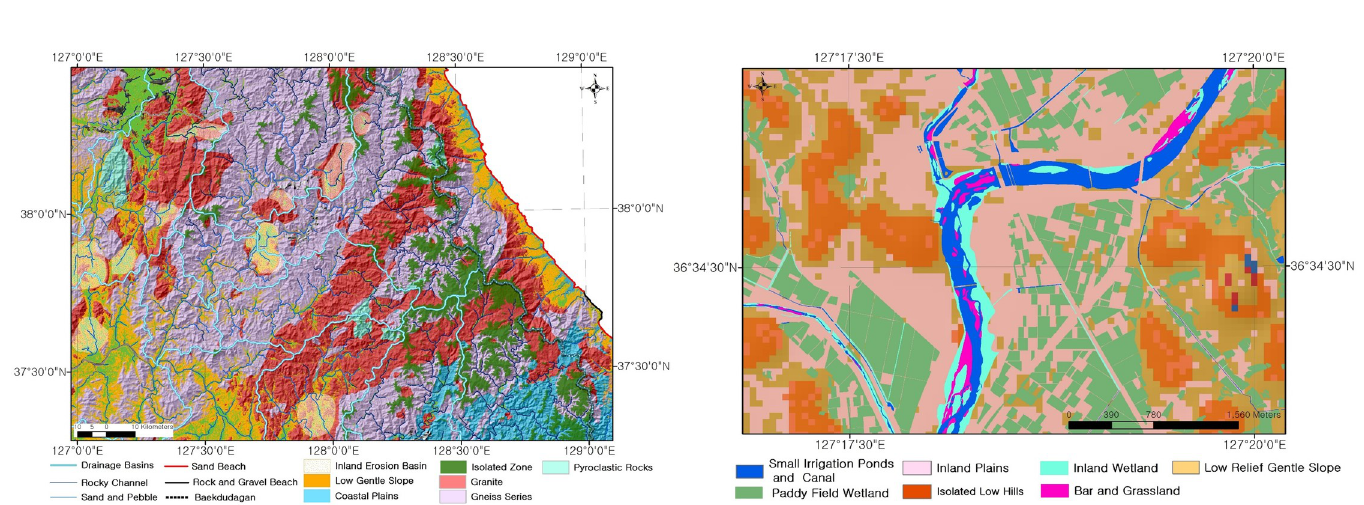
Fig 4. Result of habitat categorization by classification scale (left: Category 3, right: Category 4; base map data source: Https://gadm.org/). Categories 3 and 4 are case maps. For detailed maps, see S3 File.